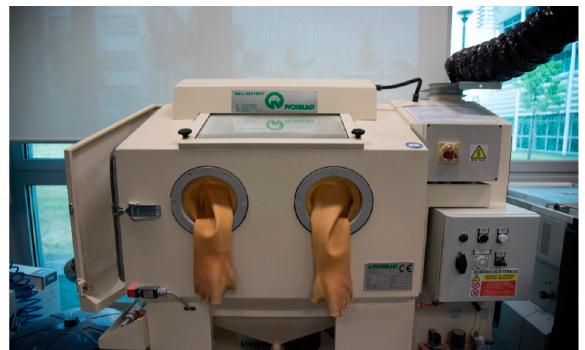
Figure 20. Sandblasting machine used to clean the fan.